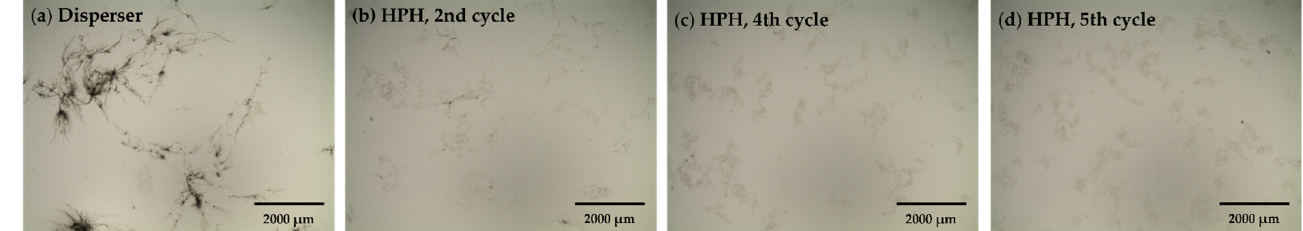
Figure 1. Microscopic images of dispersed bacterial cellulose (BC) fibers in distilled water after treatment with ( a ) a disperser and the several comminution steps (( b ) 2nd cycle, ( c ) 4th cycle, and ( d ) 5th cycle) with a high-pressure homogenizer (HPH).